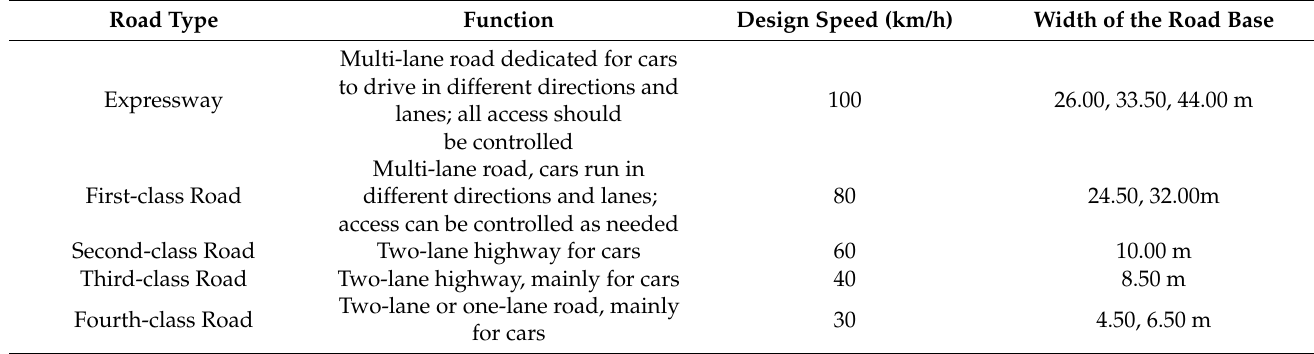
Table A1. Functions and engineering technical standards of different types of roads.